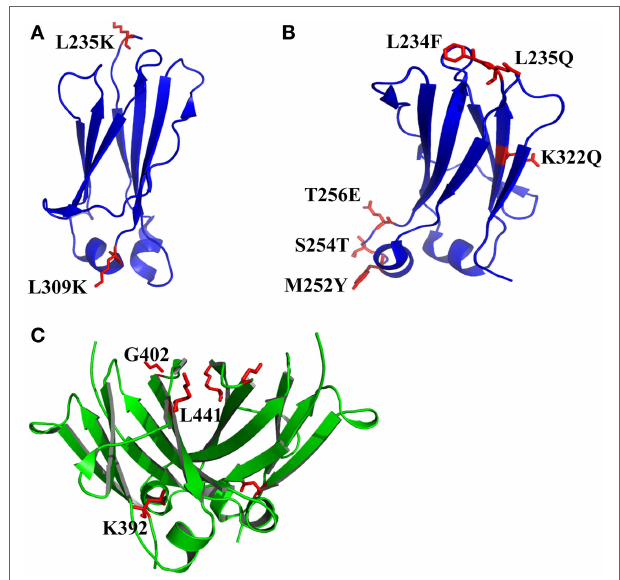
FiGURe 3 | The structures of CH2 and CH3 domains [PDB 3AVE (47)] with optimized non-covalent interactions presented by PyMOL. (A) CH2 L235K/ L309K mutant. (B) CH2 L234F/L235Q/K322Q/M252Y/S254T/T256E mutant (FQQ–YTE). (C) The residues K392, G402, and L441 in human IgG1 CH3 domain, which can be used to replace the corresponding residues in the bovine CH3 domain (G197, S207, and T246) for increase of the stability. The mutated residues for additional disulfide bonds are colored by